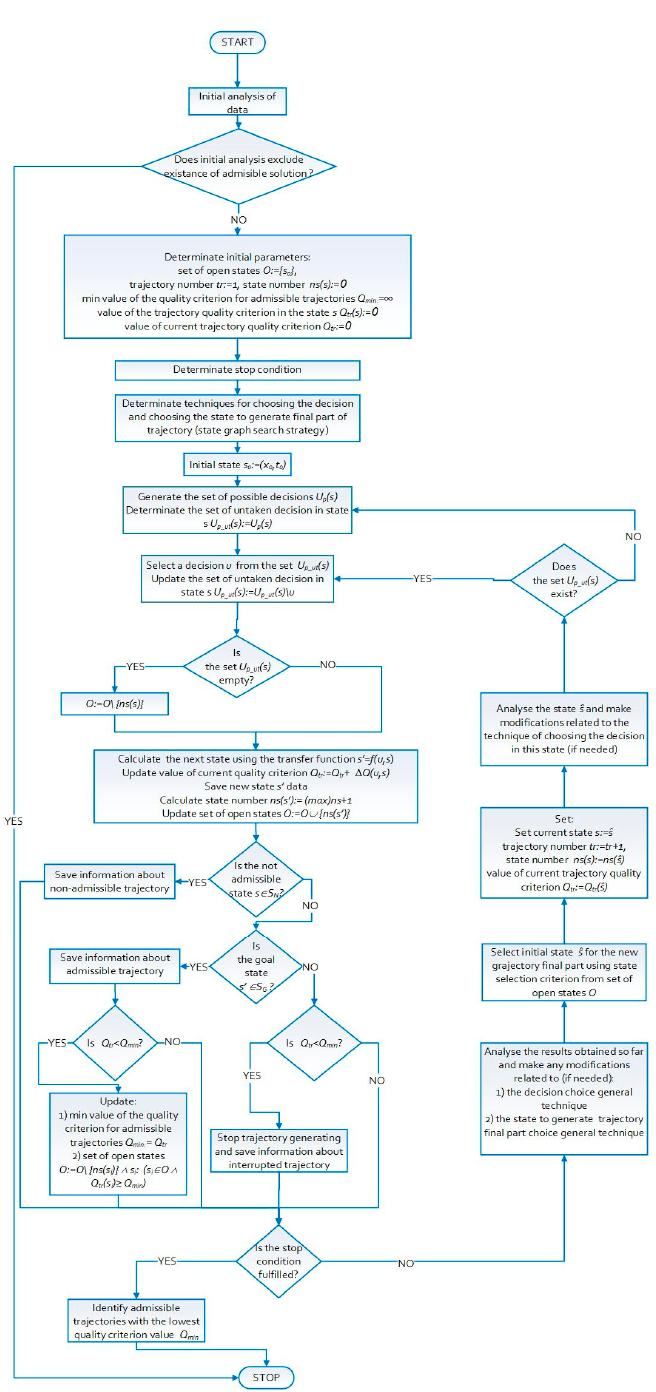
Figure 3. Scheme of algorithm.